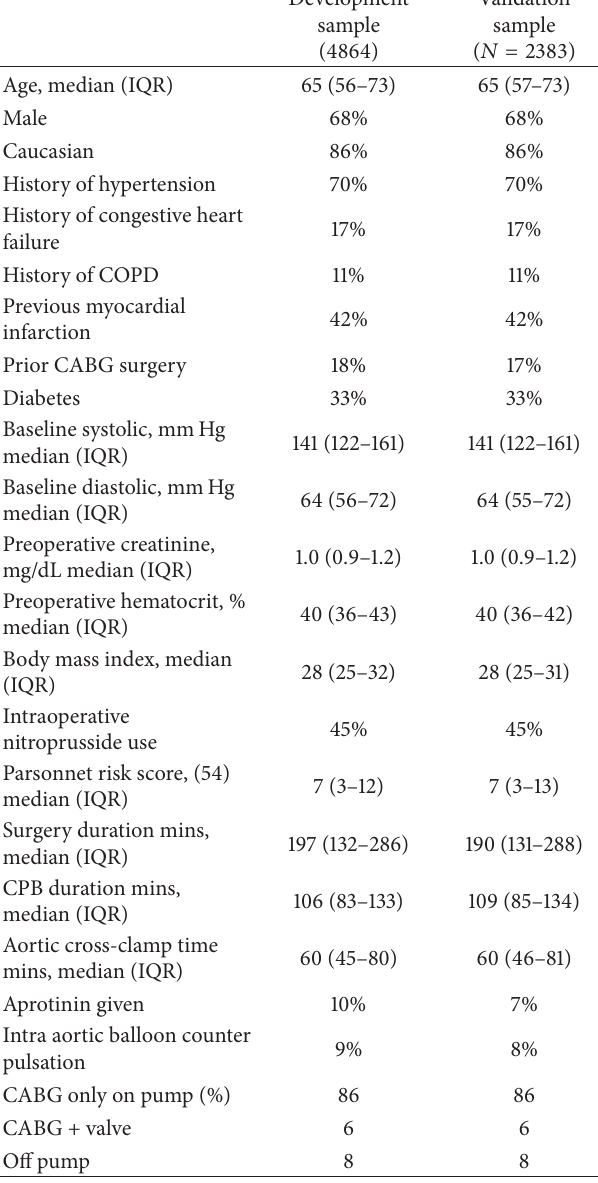
Table 1: Patient characteristics and procedural and renal